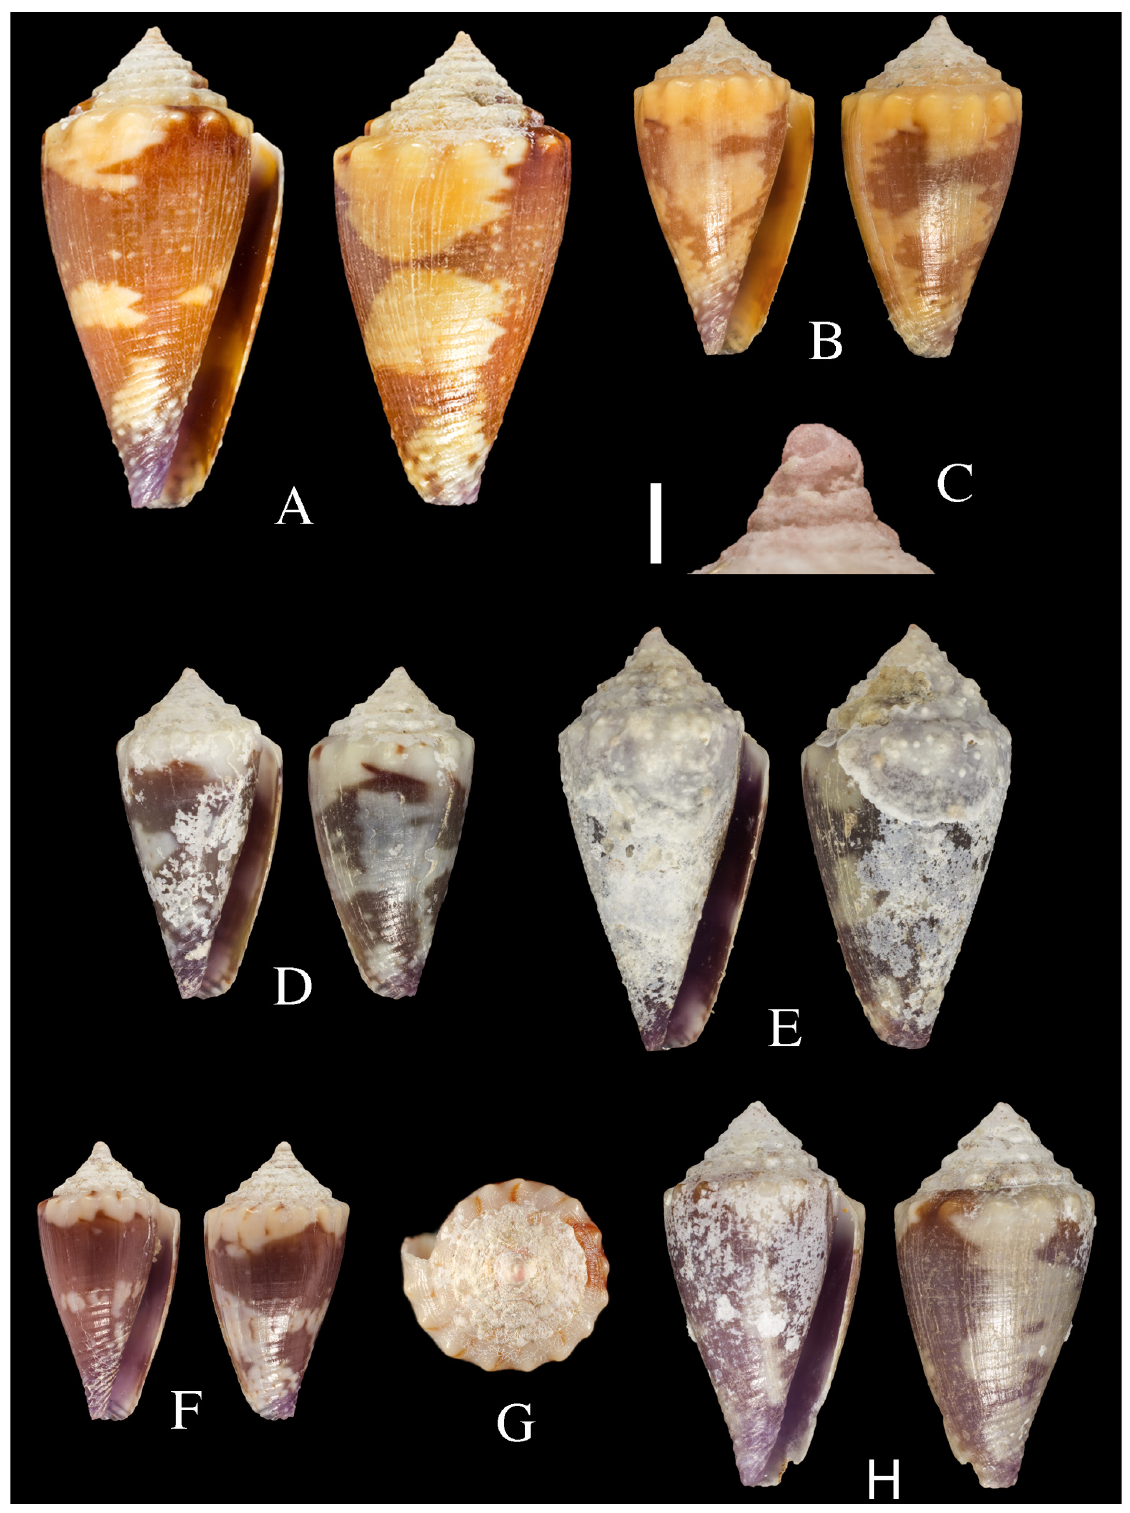
Fig. 2. Conus hughmorrisoni sp. nov. A . Holotype, 20.4 mm. B–C . Paratype 1, 13.25 mm. B . Teleoconch. C . Protoconch (scale bar = 0.5 mm). D . Paratype 2, 12.55 mm. E . Paratype 3, 16.5 mm. F–G . Paratype 4, 10.8 mm. F . Teleoconch. G . Top view. H . Paratype 5, 14.15 mm. All pictures by Manuel Caballer Gutierrez (credits project E-Recolnat,